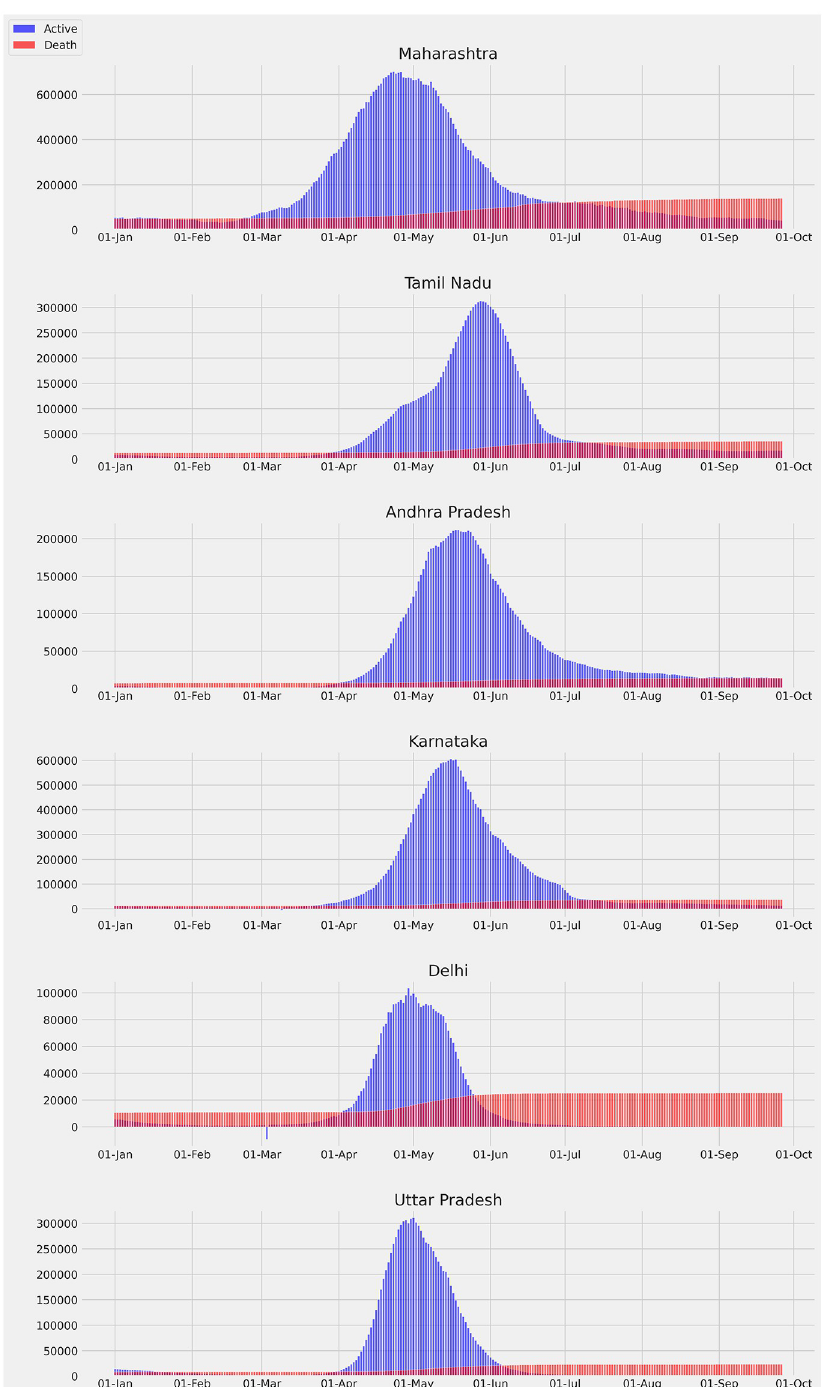
Fig 6. Daily active cases and cumulative death in key states of India for 2021 [15].